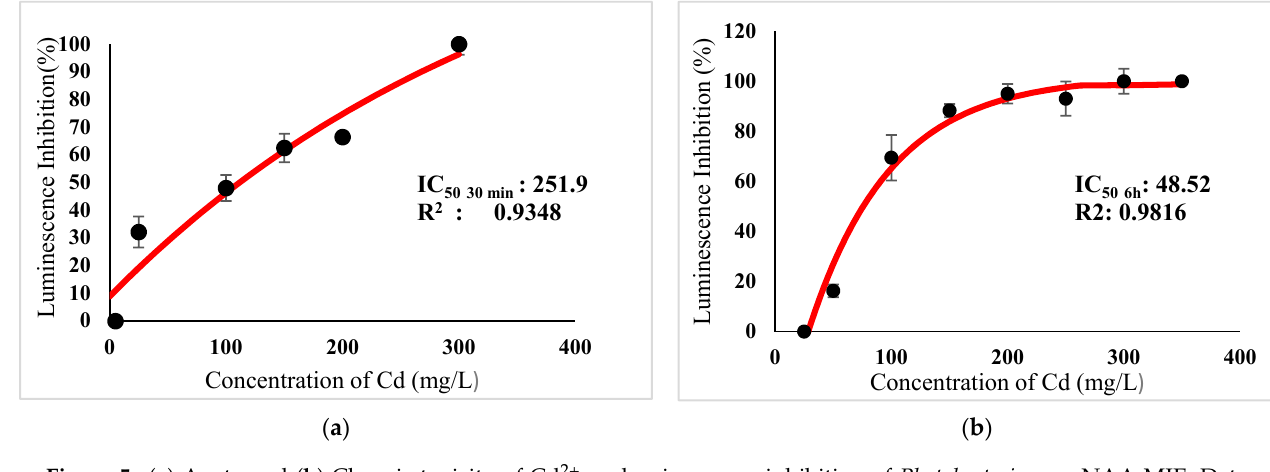
Figure 5. ( a ) Acute and ( b ) Chronic toxicity of Cd 2+ on luminescence inhibition of Photobacterium sp.NAA-MIE. Data represent mean ± SD, n = 3.